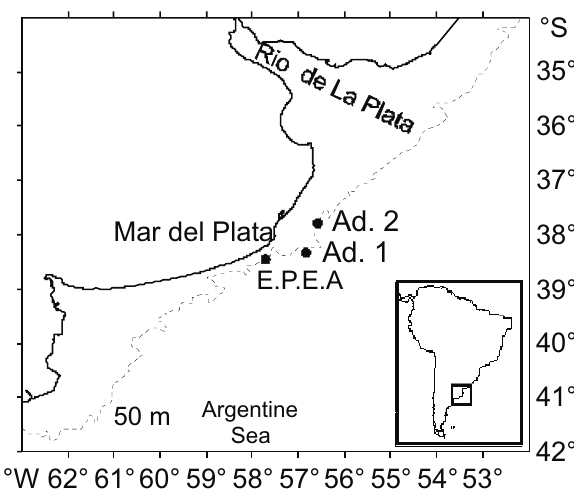
Fig . 1. – Study area and sampling sites for anchovy larvae off the Argentinean coast (SW